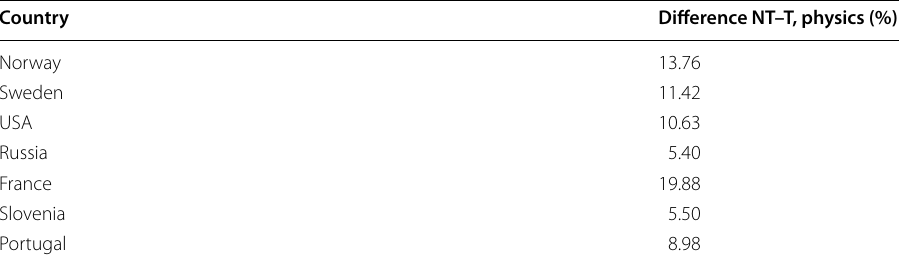
Table 8 Differences between average p -values for NT items and T items in